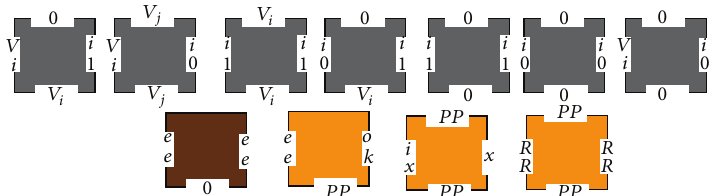
Figure 3: The meaning of tiles in 𝑇 𝑡 , and 𝑉 𝑖 indicates the vertex 𝑉 𝑖 in the graph; 𝑉 𝑖 can be used to check the presentation of vertex 𝑉 𝑖 in the subset: if so, the tile outputs 𝑥 = 1 , otherwise 𝑥 = 0 .